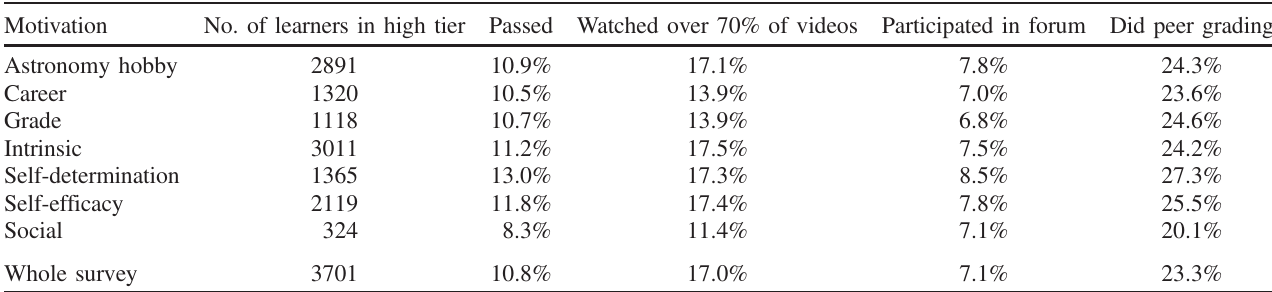
TABLE IX. Percentages of learners satisfying the given engagement indicator in high tiers of each motivational category.